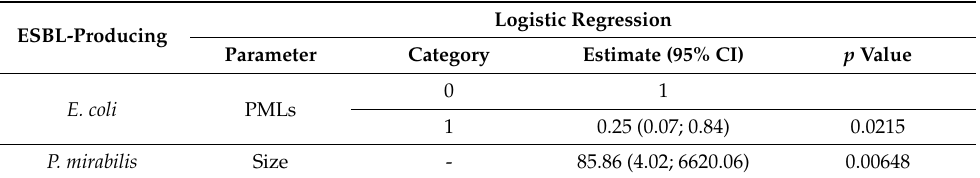
Table 5. Associations of ESBL-producing Enterobacteriaceae with herd characteristics and adminis- tration of